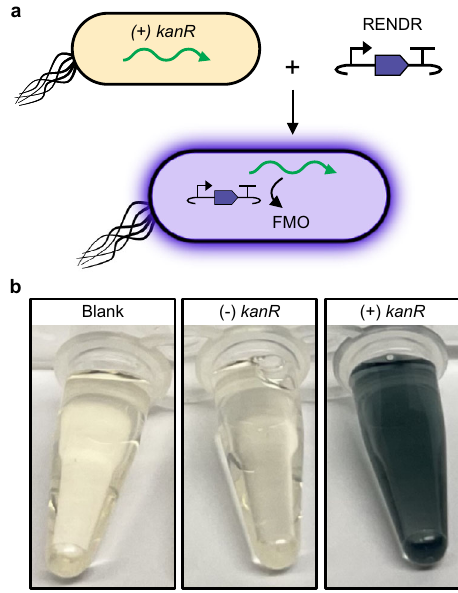
Fig. 6 | RENDR enables robust colorimetric detection of antibiotic-resistant microbes.a SchematicofusingRENDRtodetectkanamycin-resistantcells.RENDR was transformed into E. coli containing (+kanR) or lacking ( − kanR) a plasmid expressing a kanamycin resistance gene. When kanR mRNA is present, it activates RENDR, allowing for the production of an FMO output that catalyzes the produc- tion of indigo. b Photosof indigo extracted from each sample culture.Source data for ( b ) are provided as a Source Data fi le.